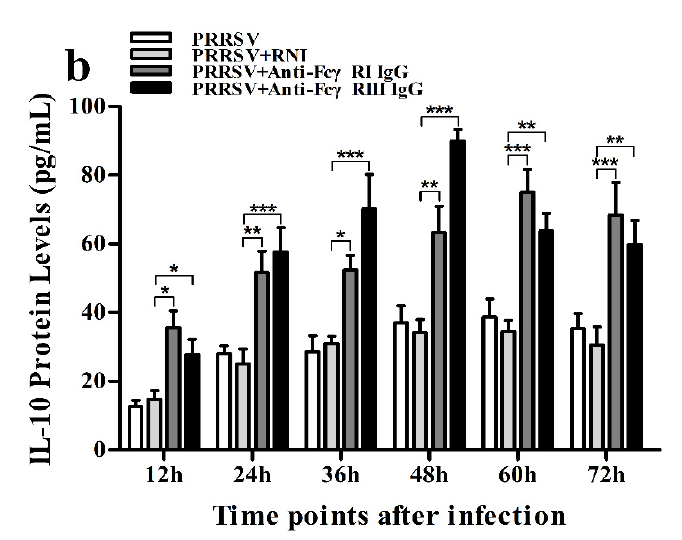
Figure 14. Effect of Fc γ RI or Fc γ RIII on PRRSV-induced protein expression of cytokines in porcine AMs. Cytokine protein levels in culture supernatants of PRRSV-infected cells pretreated with RNI, anti-Fc γ RI IgG or anti-Fc γ RIII IgG were detected by using ELISA Kits. ( a ) IFN- α protein level, ( b ) IL-10 protein level. *** p < 0.001, ** p < 0.01, * p < 0.05.